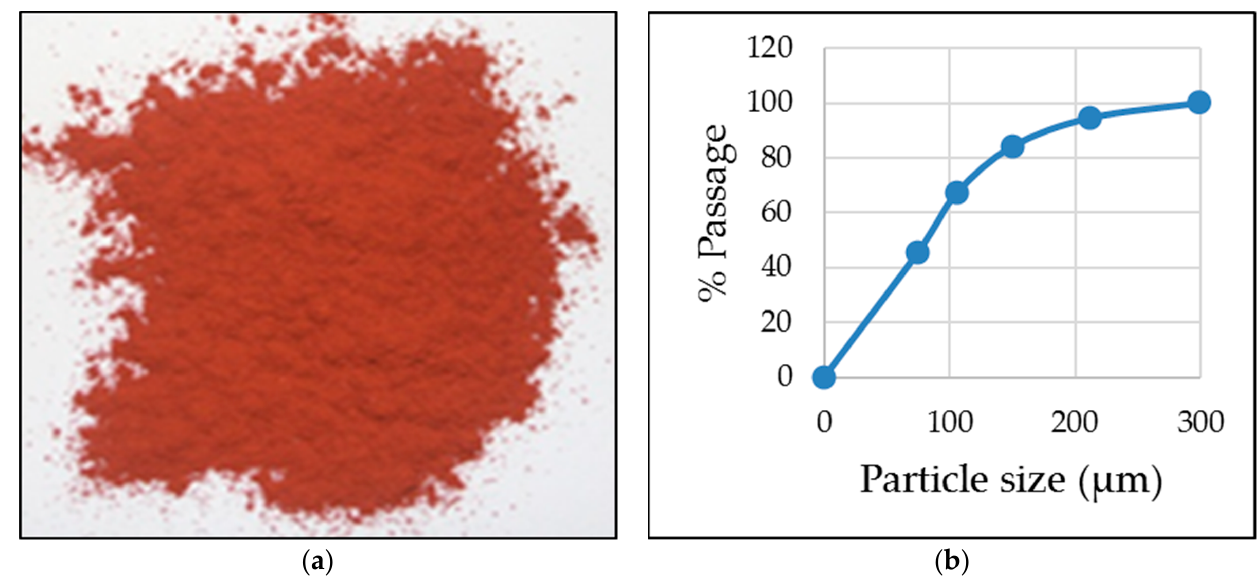
Figure 1. ( a ) Seawater-neutralized bauxite residue (BR); ( b ) particle distribution of